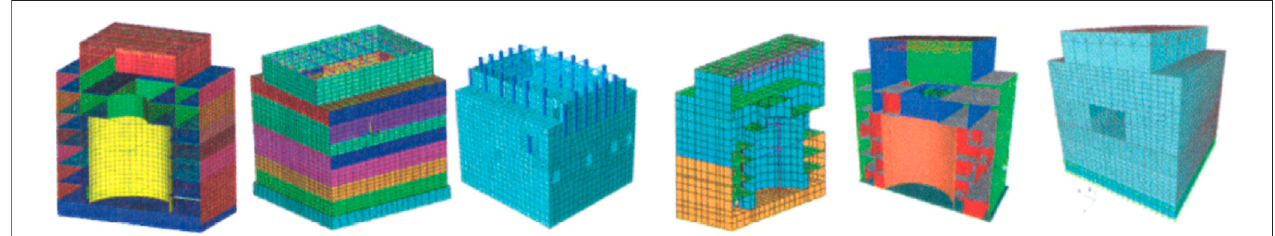
FIGURE 2 | 3D FEM models used in KARISMA benchmark exercise (IAEA,